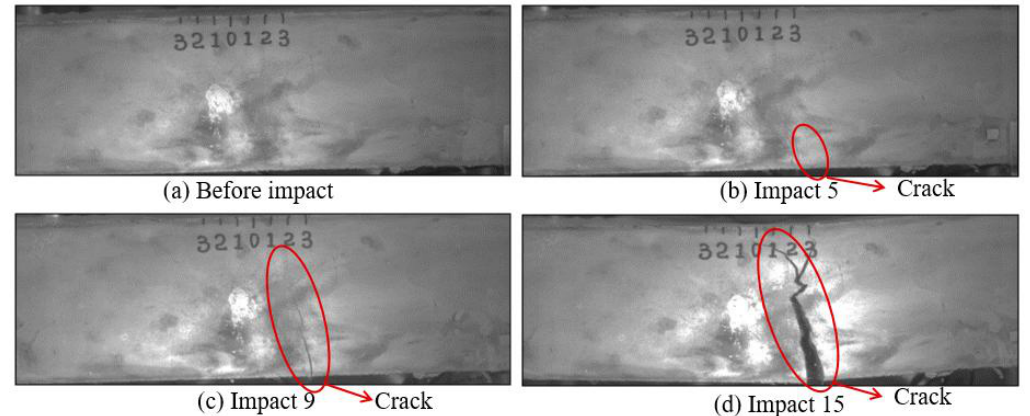
Figure 13. Results of crack detection in PVA-ECC-2 with high-speed video.